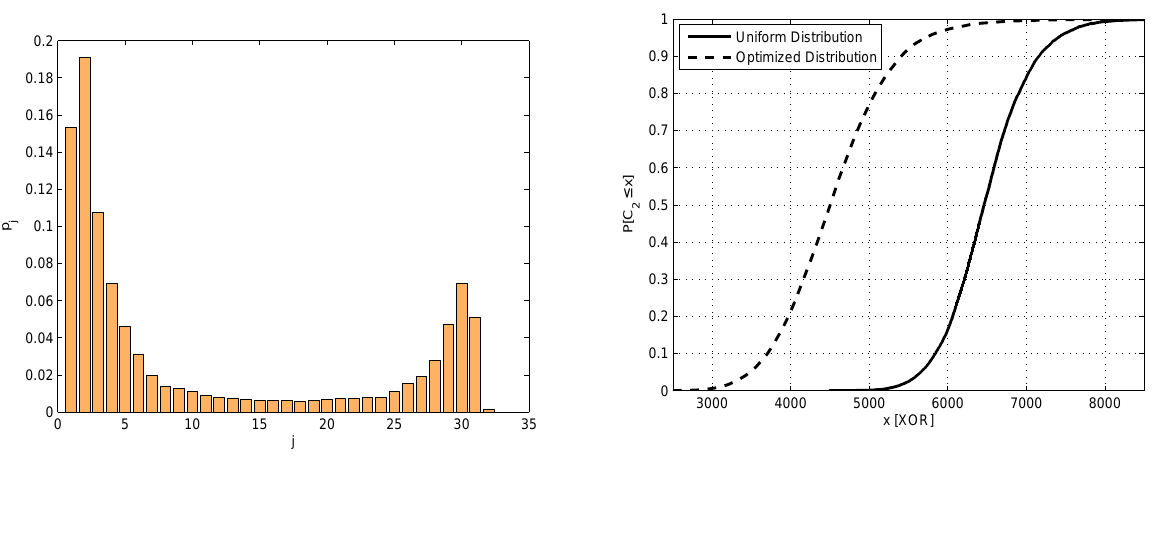
Figure 7. Decoding cost comparison. Probability that the number of XORs needed for decoding a program page is at most x . Reproduced with permission from IEEE [44].